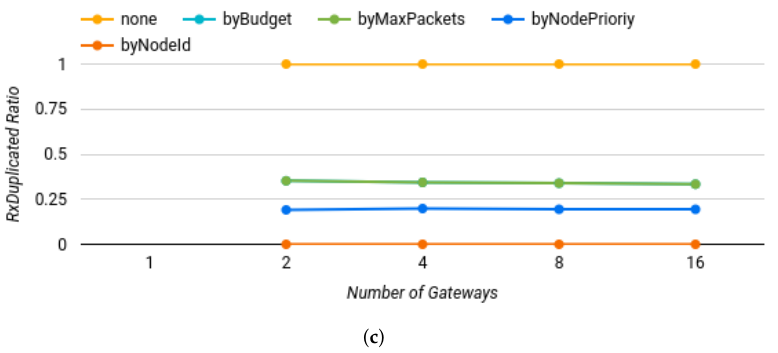
Figure 8. Summary of the baseline simulation results, considering number of gateways and metrics.